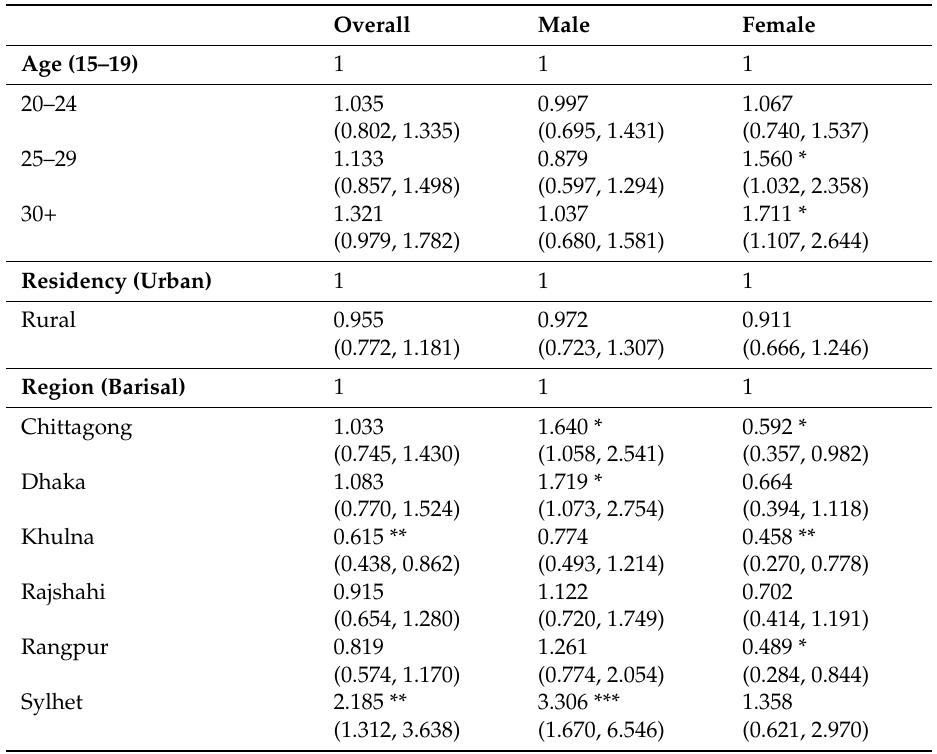
Table 3. Predictors of fever and dyspnea among under-five children in Bangladesh. Bangladesh Demographic and Health Survey